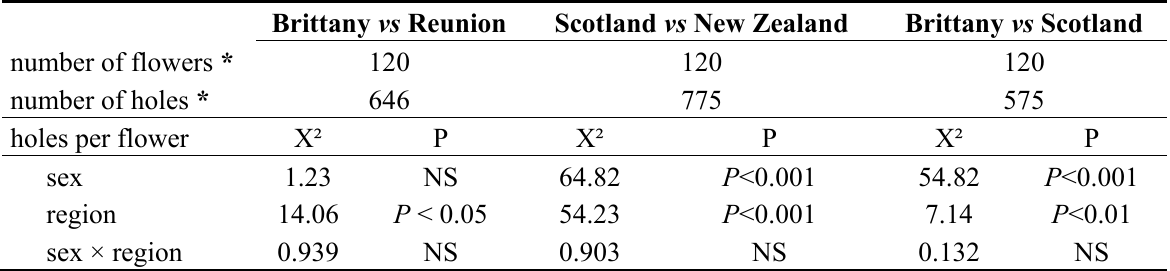
* Total numbers for each comparison.